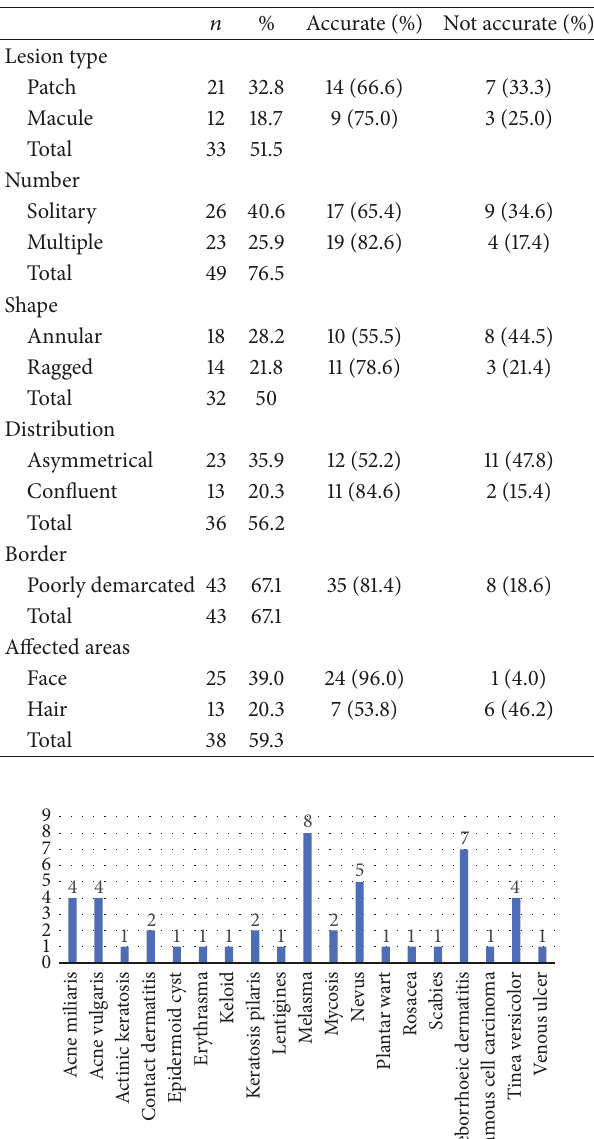
Table 4: Most frequent values for each parameter class.